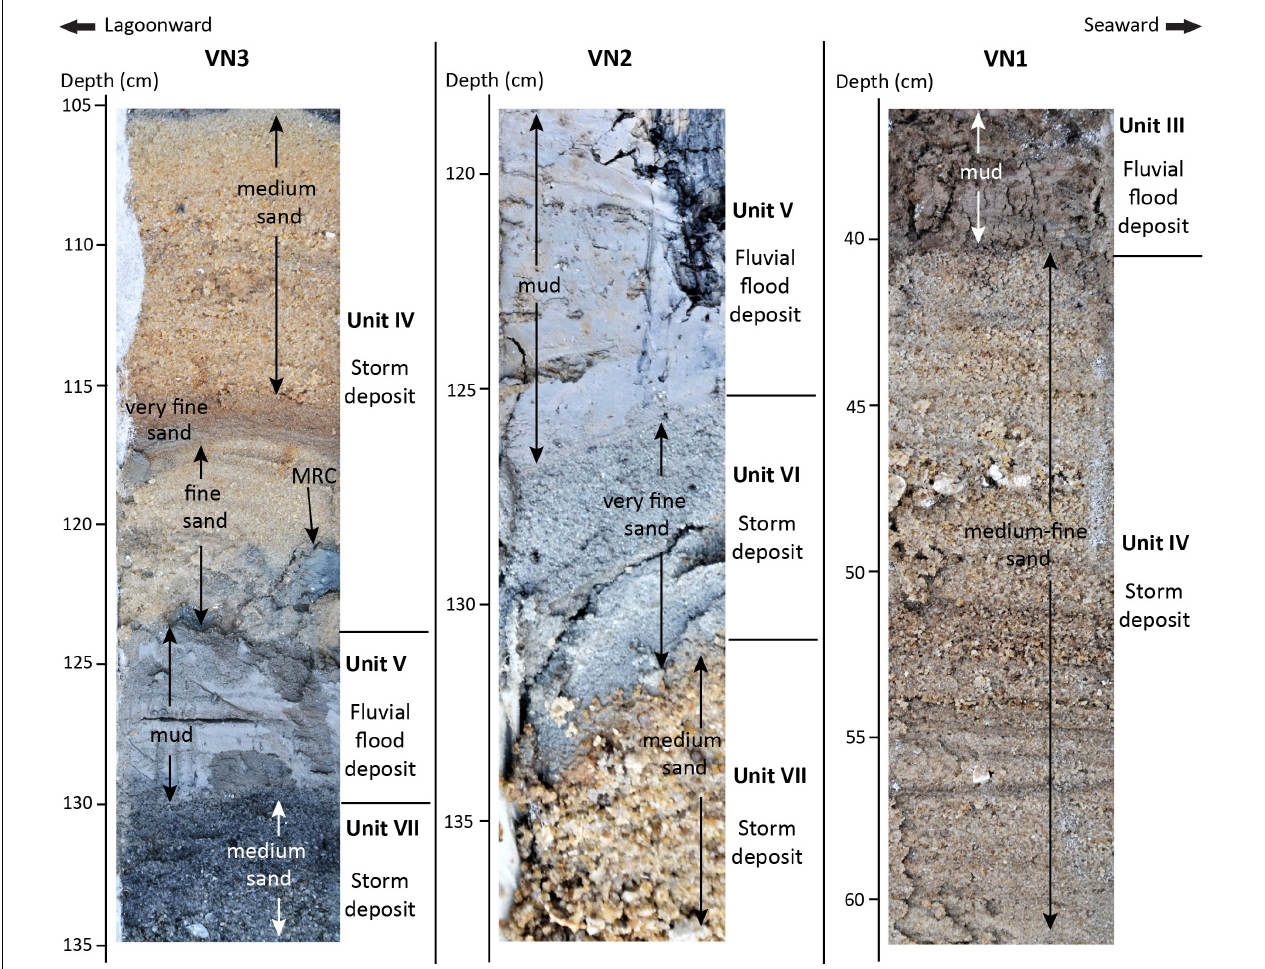
FIGURE 7 | Close-up of the internal sedimentary structures of storm deposits and FFDs from cores VN1, VN2, and VN3. In core VN1, a dark-brown mud layer with basal sharp contact was observed at 41-cm depth and parallel lamination of medium-fine sand with fragmented shells at 42–57-cm depth. In core VN2, a light-gray mud layer with basal sharp contact at 127-cm depth was deposited on a very fine sand layer. Then, medium sand with a sharp erosional top contact with a very fine sand layer was observed at a 133-cm depth. In core VN3, very-fine-to-medium sand with basal sharp contact and parallel lamination was observed at 115–118-cm depth plus an MRC at 121-cm depth, and then a light-gray mud with basal sharp contact deposited on a dark-gray color with medium-grained